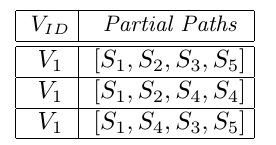
Table 1. Path table of vehicle i for time period j